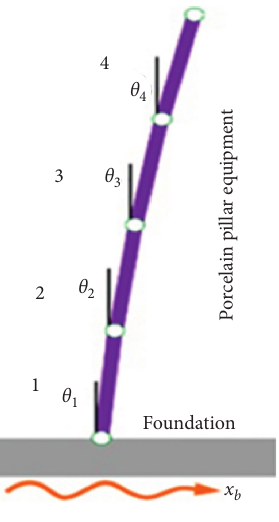
Figure 5: Analysis diagram of porcelain pillar equipment.